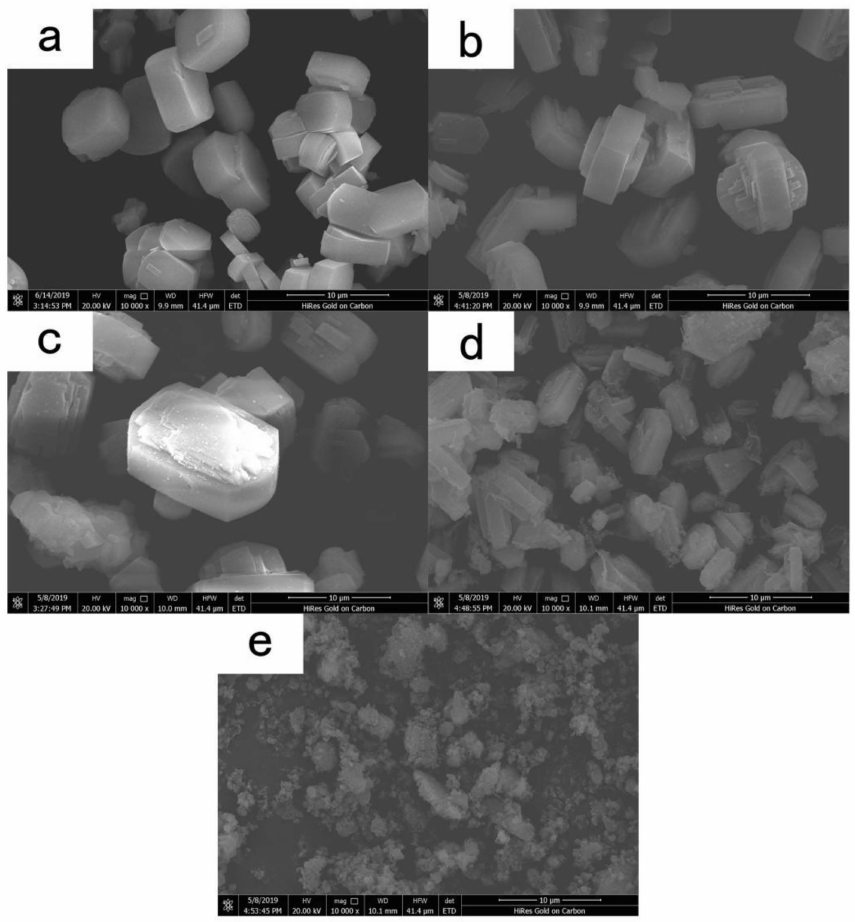
Figure 3. SEM morphology of pure ZSM-5 ( a ) and composite products with different Zn/Si ratios Zn-ZSM-5 n(Zn)/n(Si) of: ( b ) 1:200; ( c ) 1:100; ( d ) 1:50; ( e )